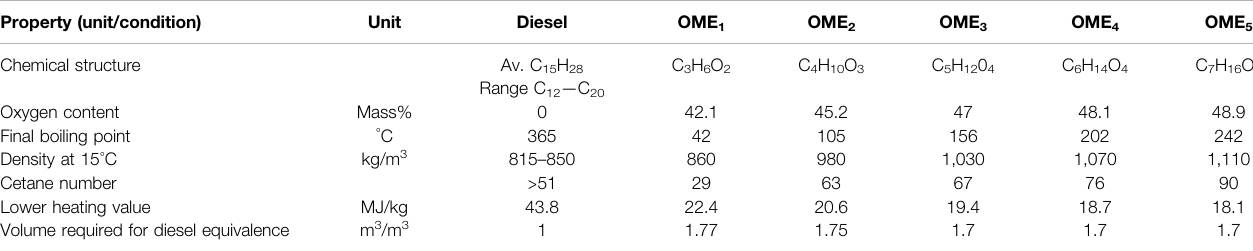
TABLE 2 | Comparison of OME x and diesel properties. Property (unit/condition)